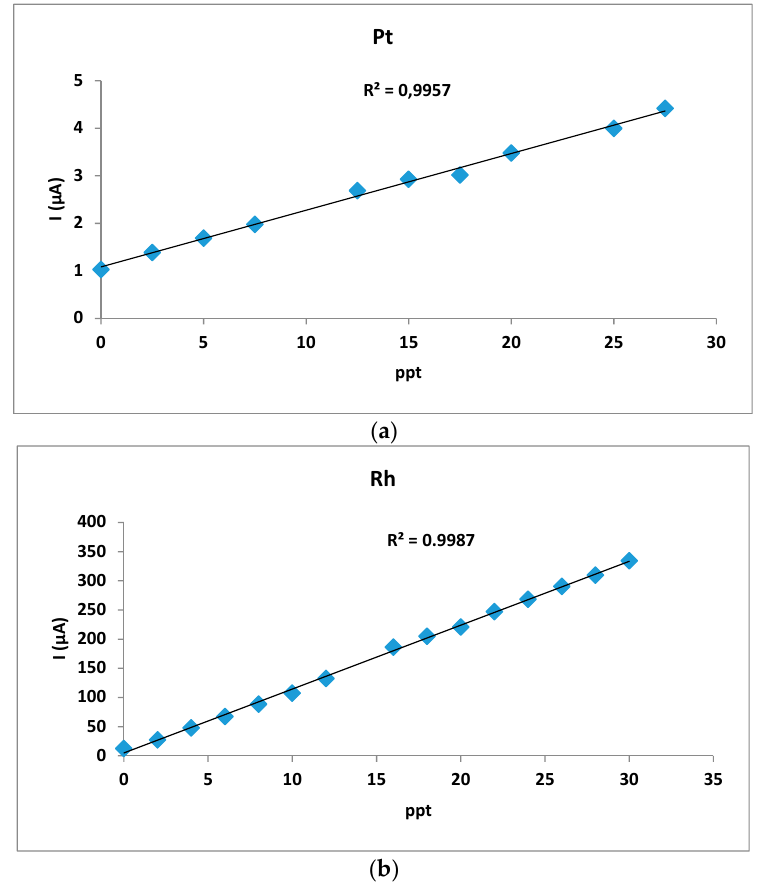
Figure 2. The calibration curves. ( a ) Voltammetric curves for platinum. ( b ) Voltammetric curves for rhodium.